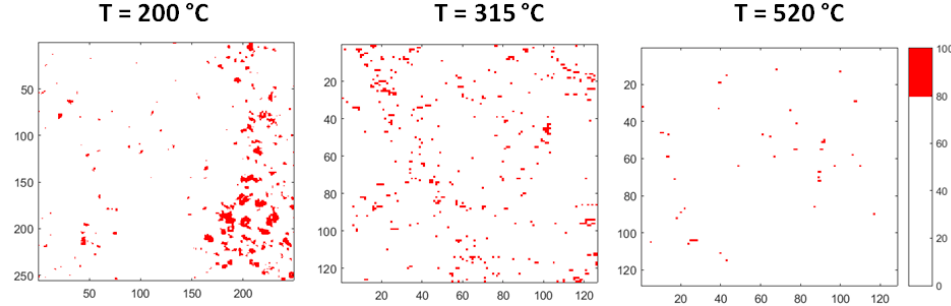
Figure 11. Evolution of the areas rich in Bi: The images are obtained by plotting in red colour only the zones where Bi content is in the range of 80–100 at %.